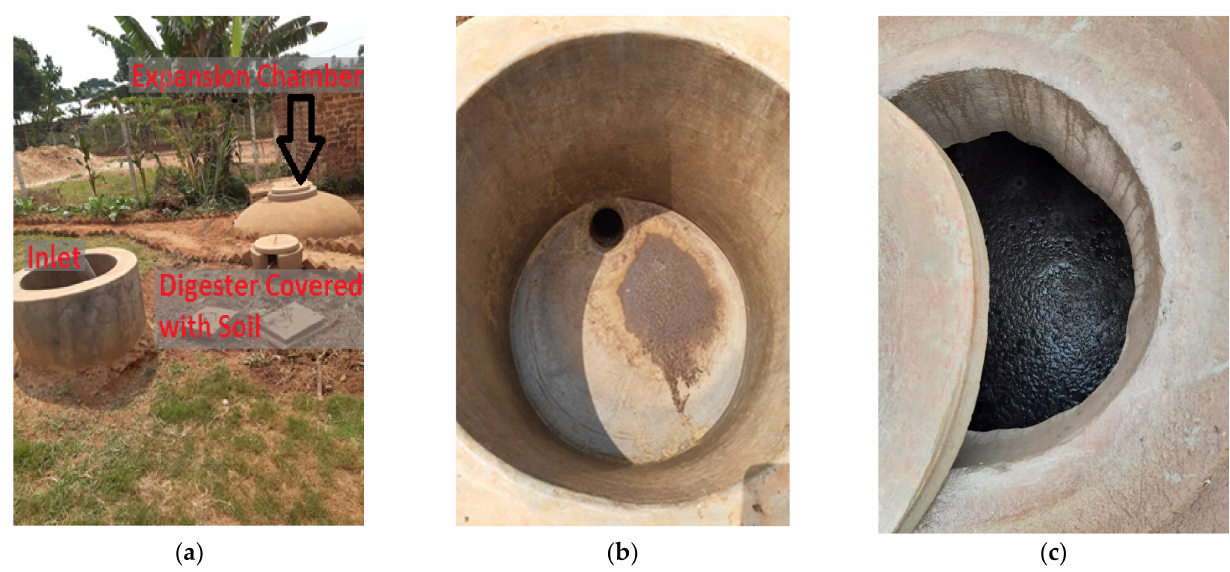
Figure 6. ( a ) Side view of the expansion chamber and inlet ( b ) Arial view of the inlet and ( c ) Aerial view of open expansion chamber with slurry exposed to ambient